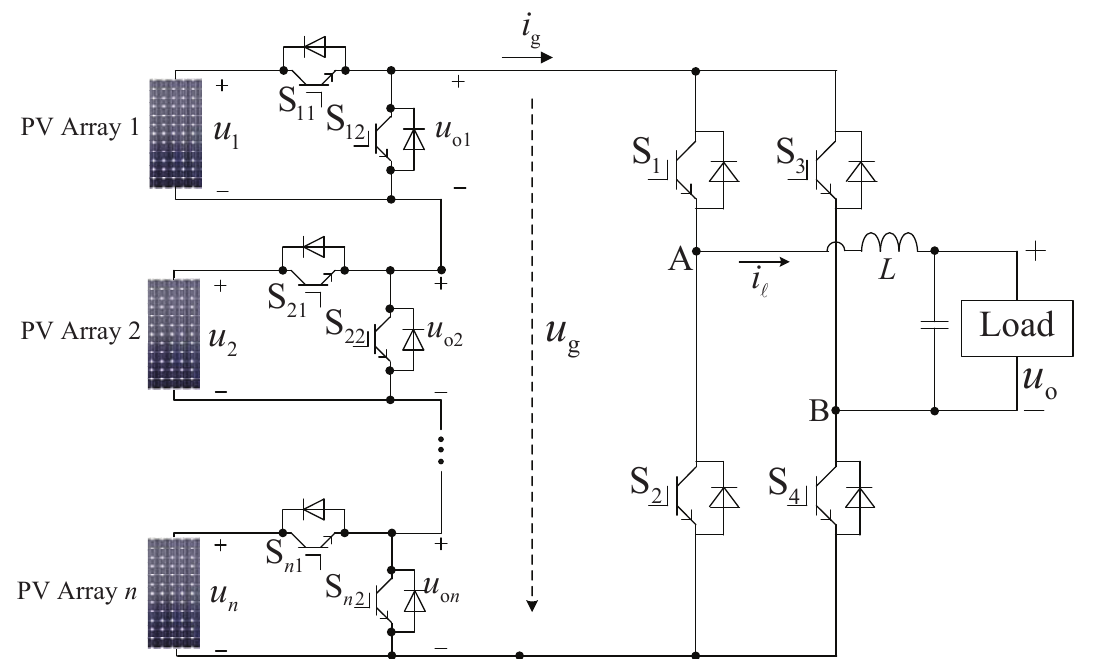
Figure 1. Standalone solar PV system with a cascaded half-bridge multilevel